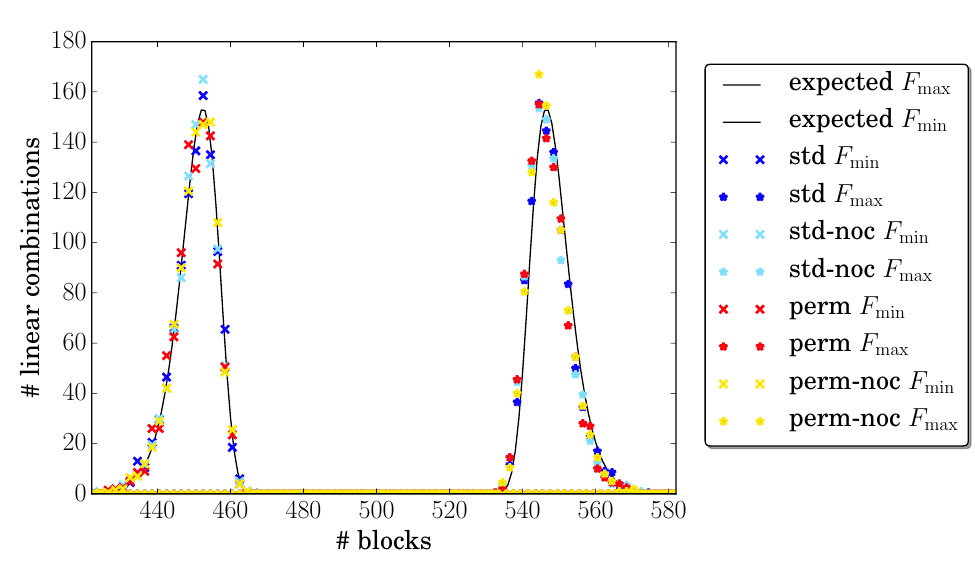
Figure 8: Distribution of f max and f min for | B | = 1000 and 2 rounds, grouped by 2.